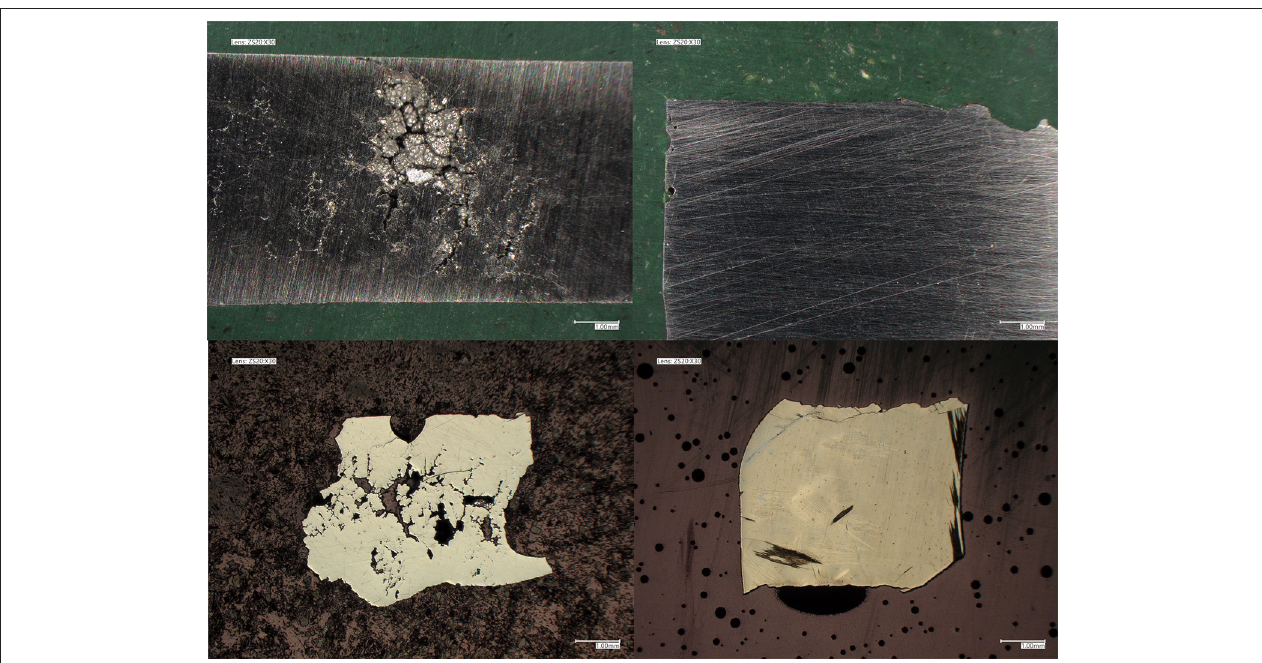
FIGURE 3 | Top and bottom left panels : examples of widespread dendrites and interconnected pores on a polished A50 sample. Top and bottom right panels : absence of dendrites and minor pores appearing on a polished B250 sample.